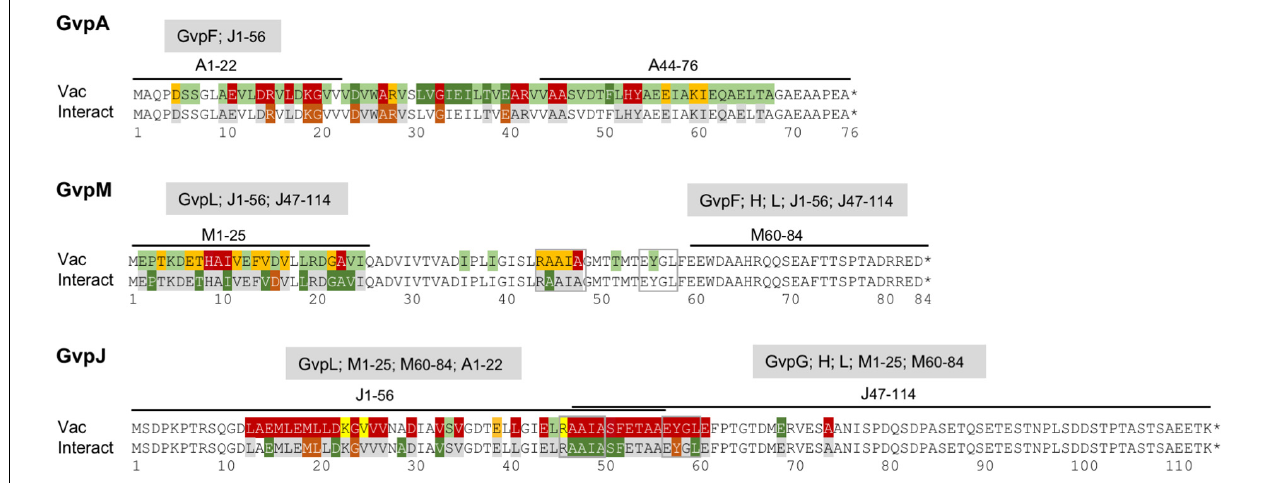
FIGURE 9 | Overview of the results obtained for the GvpA, GvpM, and GvpJ proteins in this report. The alterations leading to a Vac phenotype are compared to the results on the interaction studies, and the interaction partners of the fragments applied in the split-GFP analyses are indicated on top of the respective sequence. The colors used for shading the aa residues in each sequence are the same as in Figure 8